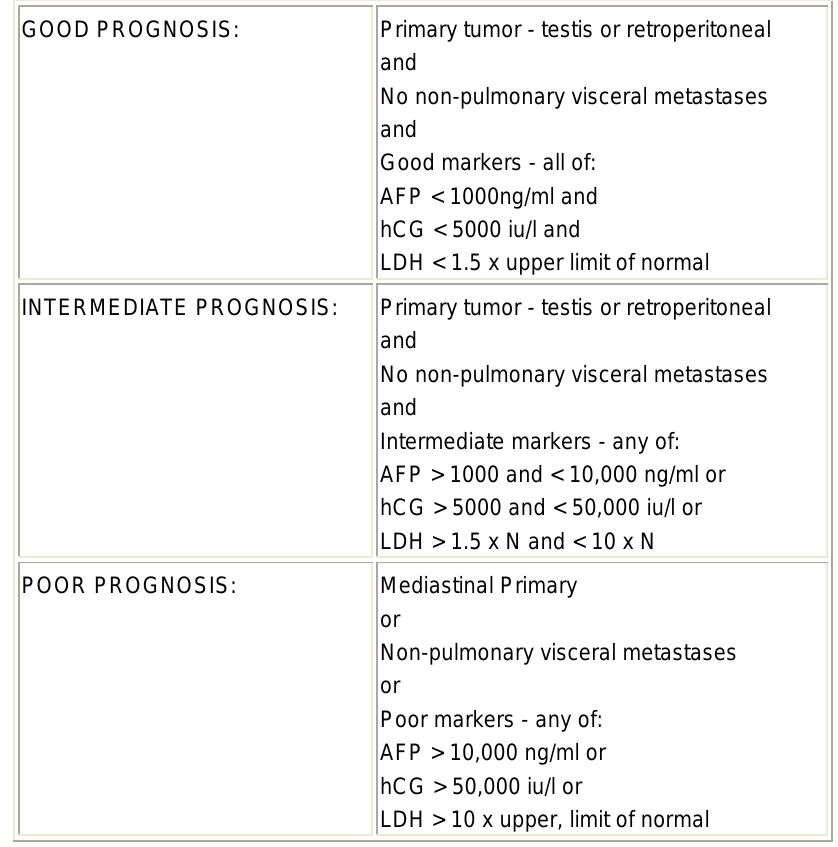
INTERNATIONAL GERM CELL CONSENSUS CLASSIFICATION FOR